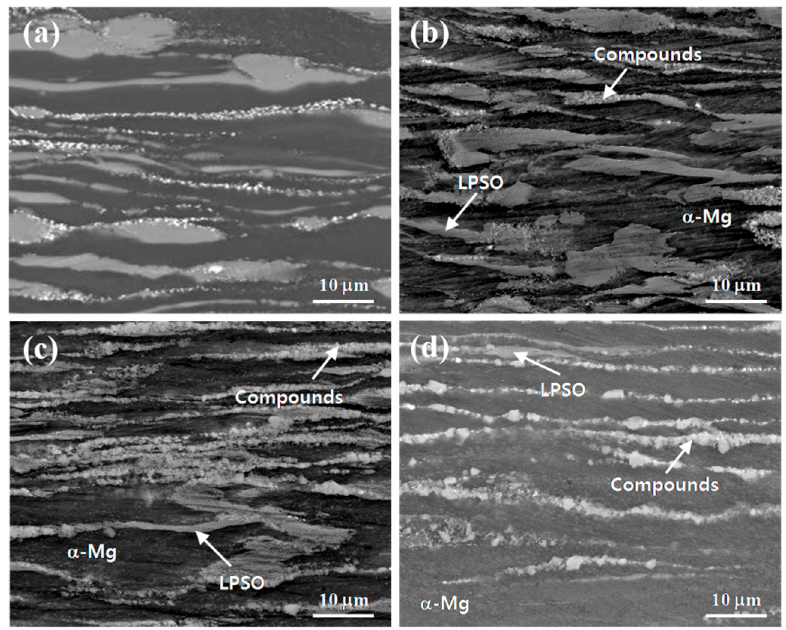
Figure 5. SEM microstructure of the extruded alloys: ( a ) Mg 88.5 Zn 5 Y 6.5 ; ( b ) Mg 88.5 Zn 5 Y 5.0 Ce 1.5 ; ( c ) Mg 88.5 Zn 5 Y 3.5 Ce 3.0 ; ( d ) Mg 88.5 Zn 5 Y 2.0 Ce 4.5 .